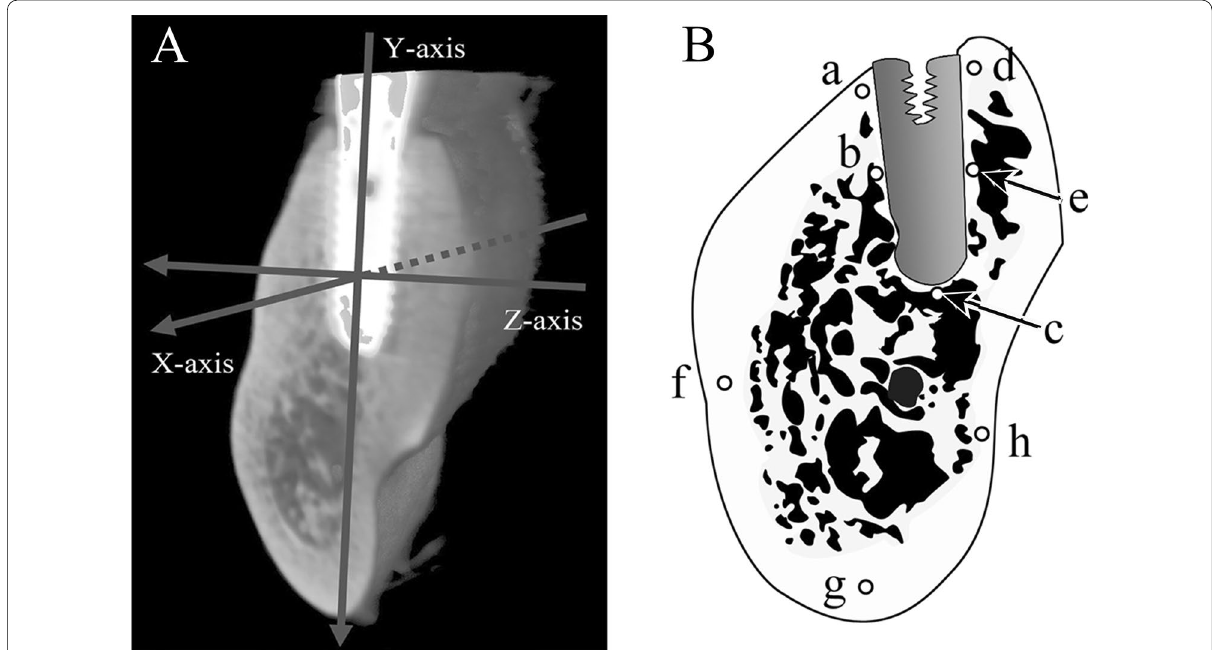
Fig. 1 Sagittal cross-sections at each measurement location Mandibular coordinate axis and sagittal cross-sections at each measurement location. A The X -axis indicates mesiodistal axis. The Y -axis indicates the implant body axis. The Z -axis indicates the buccolingual axis. B (a) Implant neck, buccal side; (b) central part of the implant, buccal side; (c) implant apex; (d) implant neck, lingual side; (e) central part of the implant, lingual side; (f) cortical bone at the base of the mandible, buccal side; (g) cortical bone at the base of the mandible; (h) cortical bone at the base of the mandible, lingual